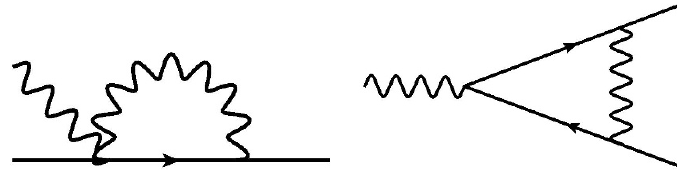
Figure 11 . Two diagrams contribute to the running of the three-point vertex. Each diagram is understood to exist in several versions, with @ t R k inserted on each of the internal lines in turn, such that each loop integral is UV